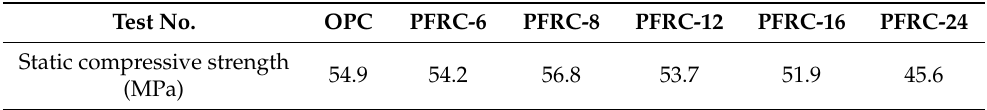
Table 6. Static compressive strengths of